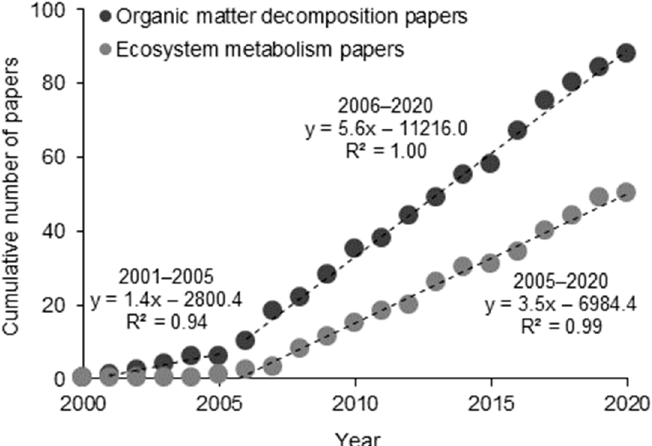
Figure 1. Cumulative number of papers addressing the use of organic matter decomposition ( n = 88) or ecosystem metabolism ( n = 50) as bioassessment tools of stream functional integrity over the last two decades. Linear regressions are shown for the periods 2001 (first study)–2005 and 2006–2020 for organic matter decomposition papers and for the period 2005 (first study)–2020 for ecosystem metabolism papers.